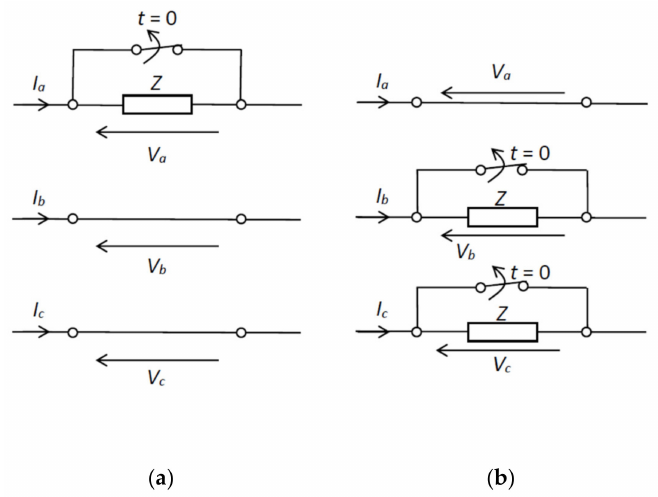
Figure 5. Circuit models for the single-line ( a ) and the double-line ( b ) switching. When t = 0, the ideal switches open, and the impedances Z are series connected to the corresponding